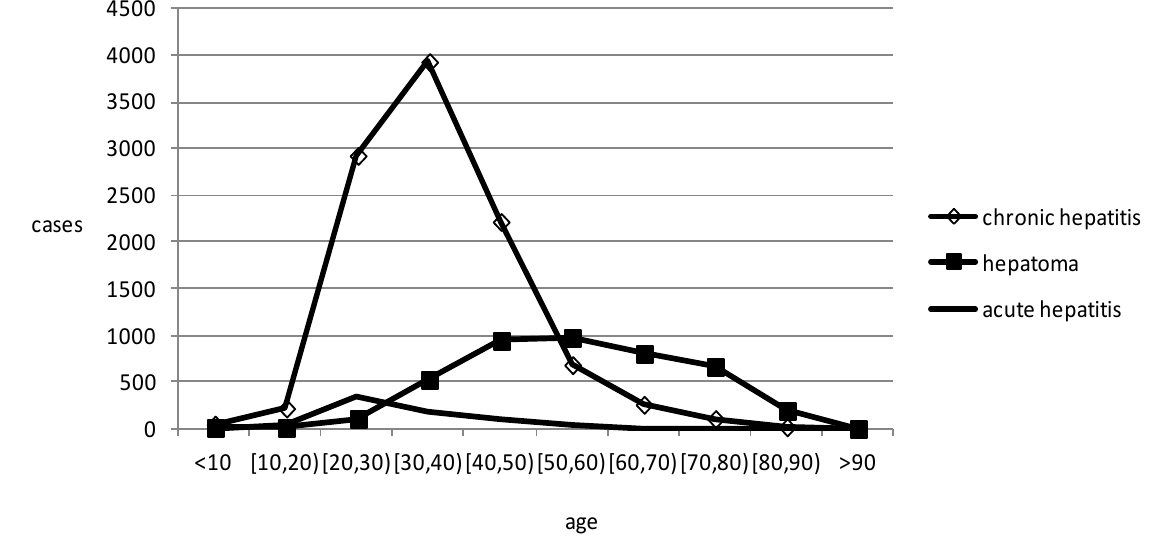
Figure 2. The age distribution of hepatitis B and hepatoma in Shenzhen from 2010 to